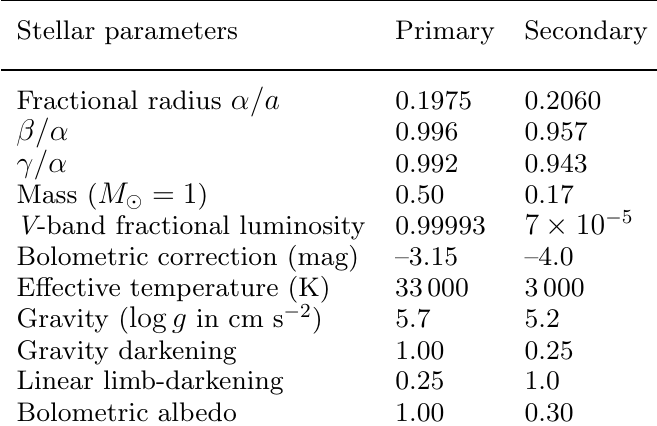
Table 3. Stellar and model